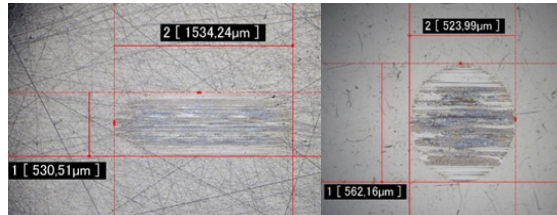
Figure 8: Wear photos of specimens used in the measurement with 1000 km ran, used oil: ball on the left and disc on the